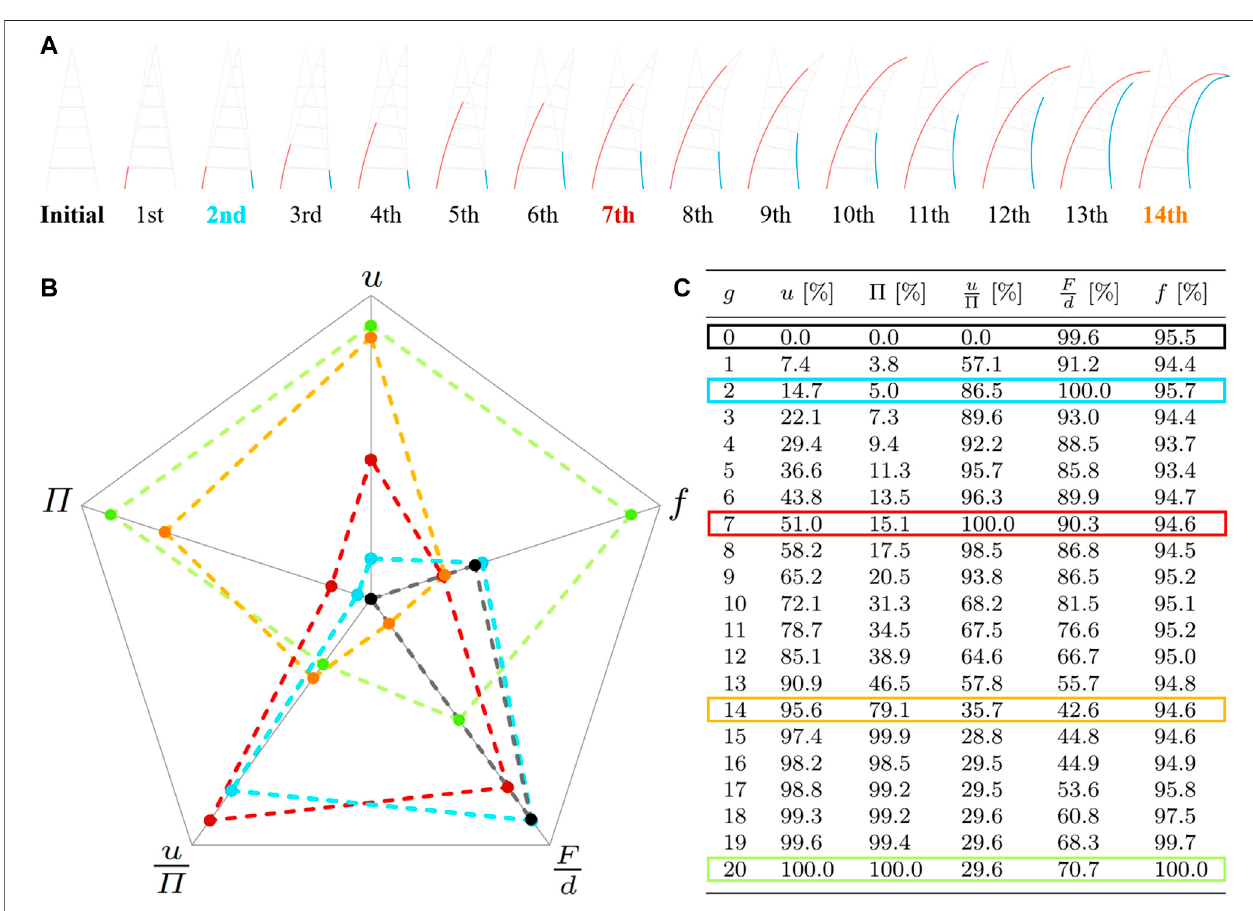
Frontiers in Built Environment |